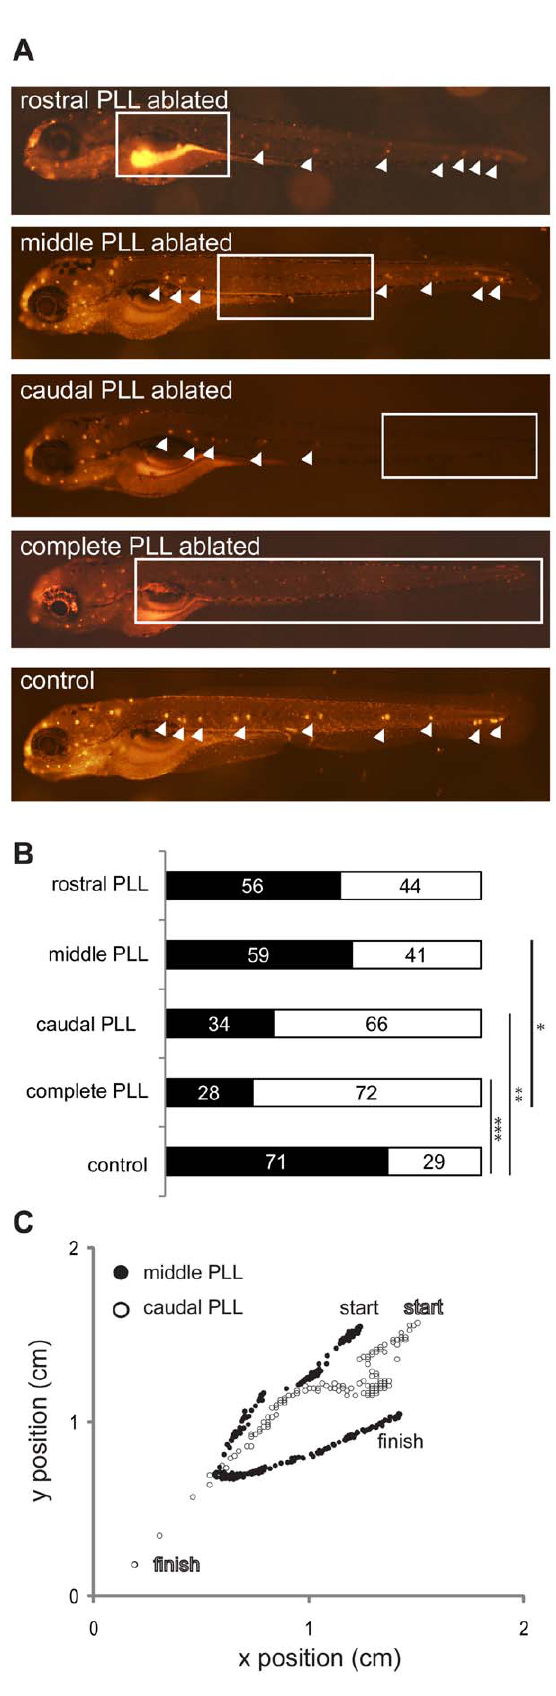
Figure 4. The effects of selective neuromast ablation on the ability of larvae to avoid a suction source. A. DASPEI-labeled neuromasts in 5 day post fertilization larvae with sections of the posterior lateral line (PLL) ablated with neomycin. Intact neuromasts labeled with DASPEI are highlighted with white arrowheads, while white boxes indicate regions where neomycin was applied. Note that due to the transparency of the larvae, at times labeled neuromasts from the opposite side of the body are seen. Five different treatments were tested, from top to bottom: (1) larvae with rostral neuromasts of the PLL ablated, (2) middle neuromasts of the PLL ablated, (3) caudal neuromasts of the PLL ablated, (4) complete PLL ablated and (5) sham treated control group. B. Percent larvae that escape (black bars) and are captured by (white bars) the suction source. There is a significant difference between the control (N=78) and the complete PLL ablated group (N=36) as well as between the control and the caudal neuromasts ablated group (N=32). We also found a significant difference between the complete PLL ablated group and middle neuromasts ablated group (N=27). No significant effects where found for the rostral neuromasts ablated group (N=18). All groups were tested using a Fisher’s exact test (***p , 0.001, **p , 0.01, *p , 0.05). C. Time series showing the position of a larva with caudal neuromasts ablated (white circles) captured by the suction source (located at the origin of the coordinate system), and a larva with middle neuromasts ablated (black circles) bursting away from the suction source. Start and endpoint of each path are indicated.